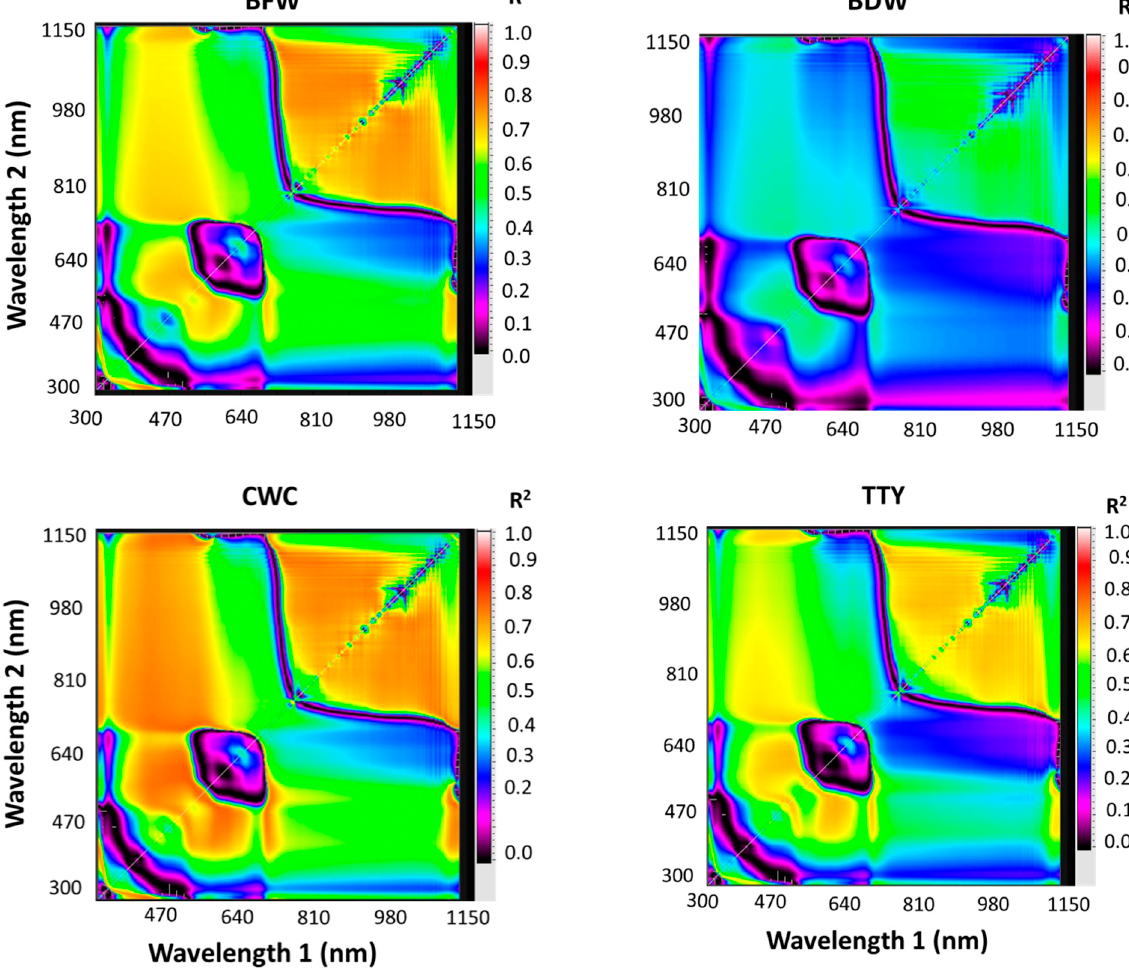
Figure 2. Correlation matrices showing the coefficients of determination (R 2 ) for dull wavelength combinations of the spectra with biomass fresh weight (BFW) biomass dry weight (BDW), canopy water content (CWC), and total tuber yield (TTY) of potato varieties subjected to different irrigation regimes across two seasons.